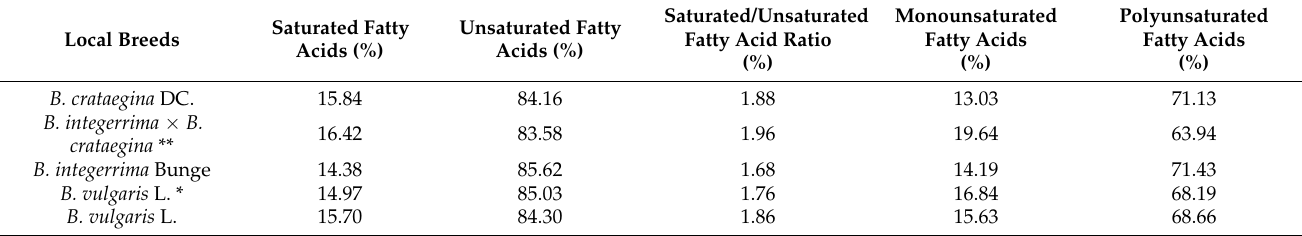
Table 2. Saturated/unsaturated fatty acids ratio, saturated, unsaturated, monounsaturated, and polyunsaturated fatty acids of Berberis